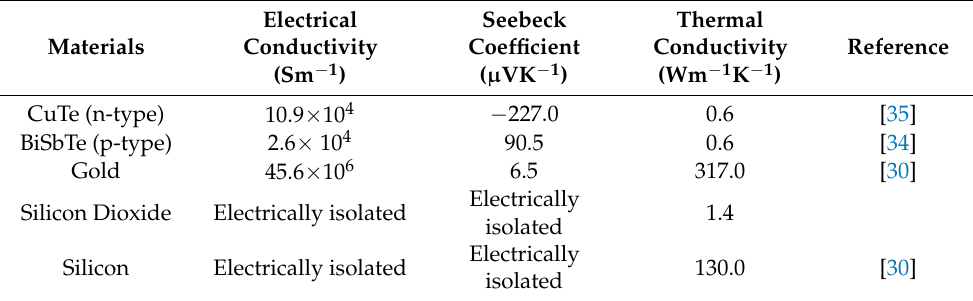
Table 1. Thermoelectric material properties measured at 300 K used for the